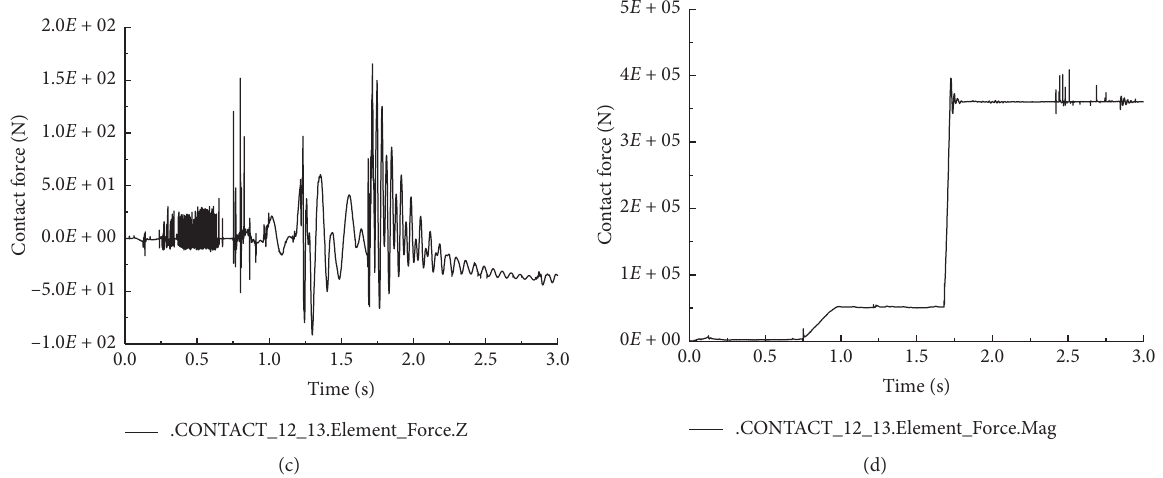
Figure 15: Contact force change between the links at the chain blocked position. (a) Contact force in the X direction. (b) Contact force in the Y direction. (c) Contact force in the Z direction. (d) Contact force amplitude.